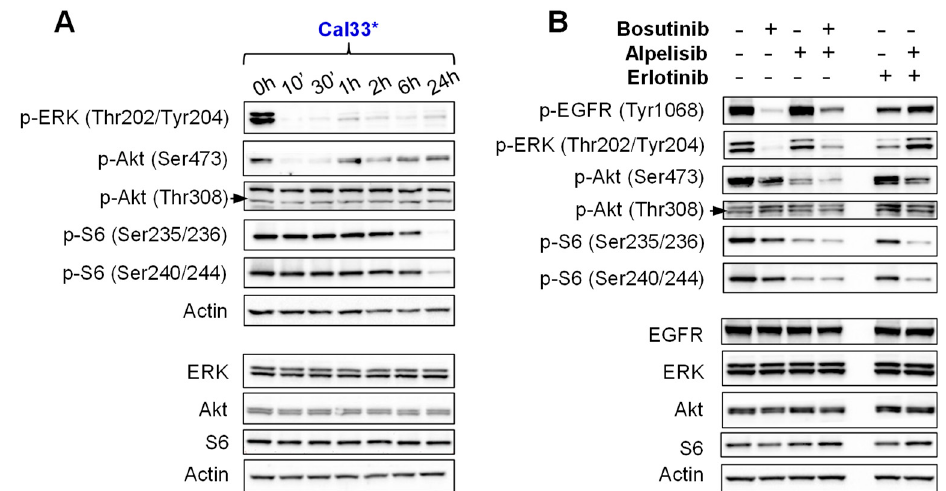
Figure 5. ( A ) Western blot analysis of ERK, Akt and S6 phosphorylation of Cal33 cells treated with the IC 50 of Bosutinib at different time points. ( B ) Western blot analysis of ERK, Akt and S6 phosphorylation of Cal33 cells treated with Bosutinib (IC 50 ), Alpelisib (IC 50 ) and Erlotinib (10 µM) at 6 h. * Mutated in PIK3CA . Black arrows indicate p-Akt Thr308.